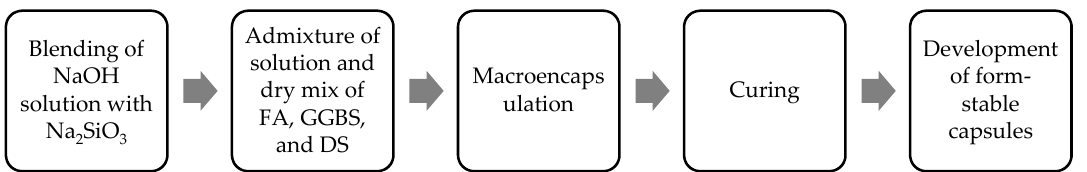
Figure 4. Illustration of the steps involved in encapsulation of PCM in LECA.